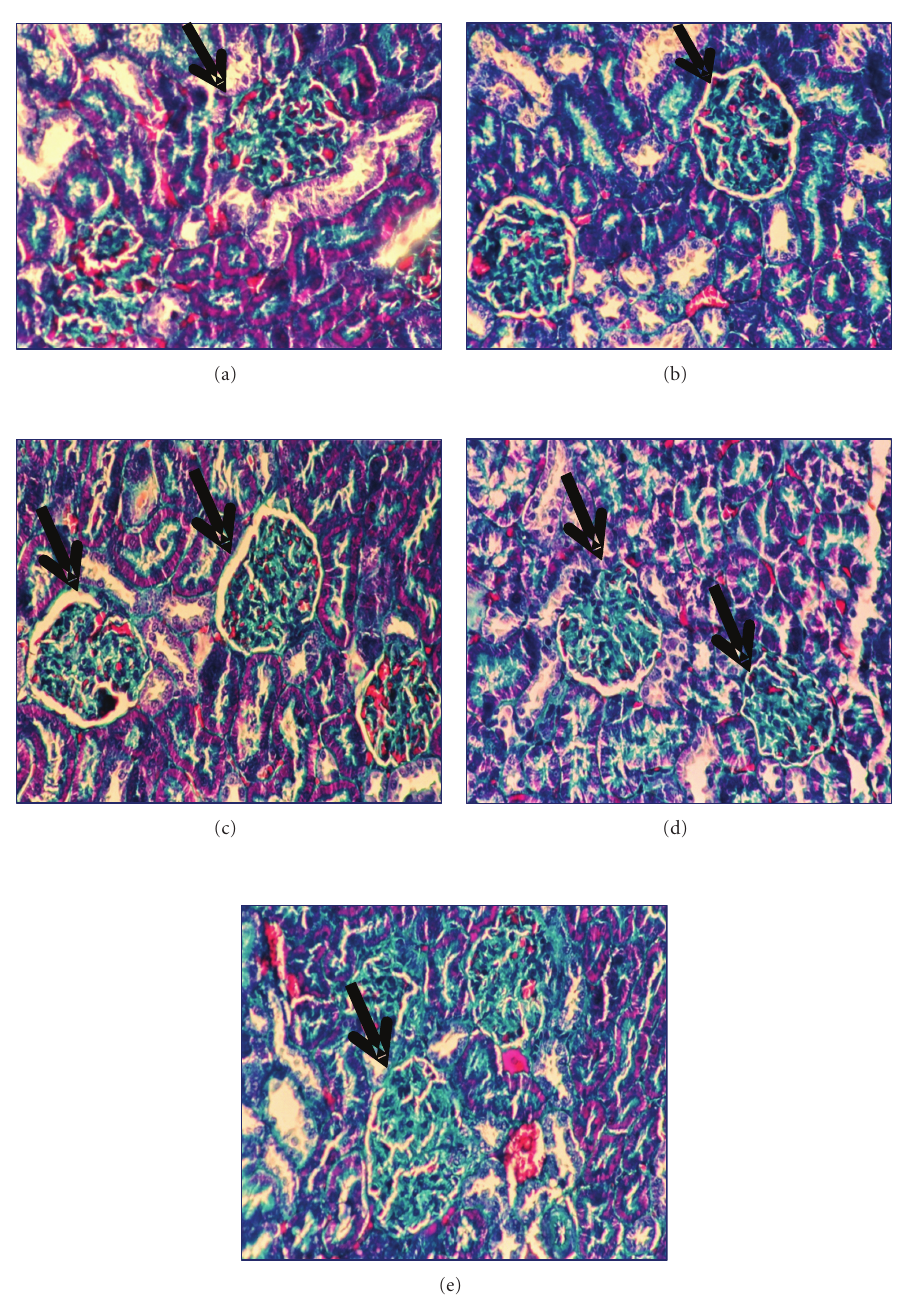
Figure 7: Photomicrography of kidney sections (200x) of CCl 4 (a), CCl 4 treated with ethanol extract (b), CCl 4 treated with chloroform extract (c), CCl 4 treated with petroleum ether extract (d), and CCl 4 treated with silymarin (e) stained with Masson’s